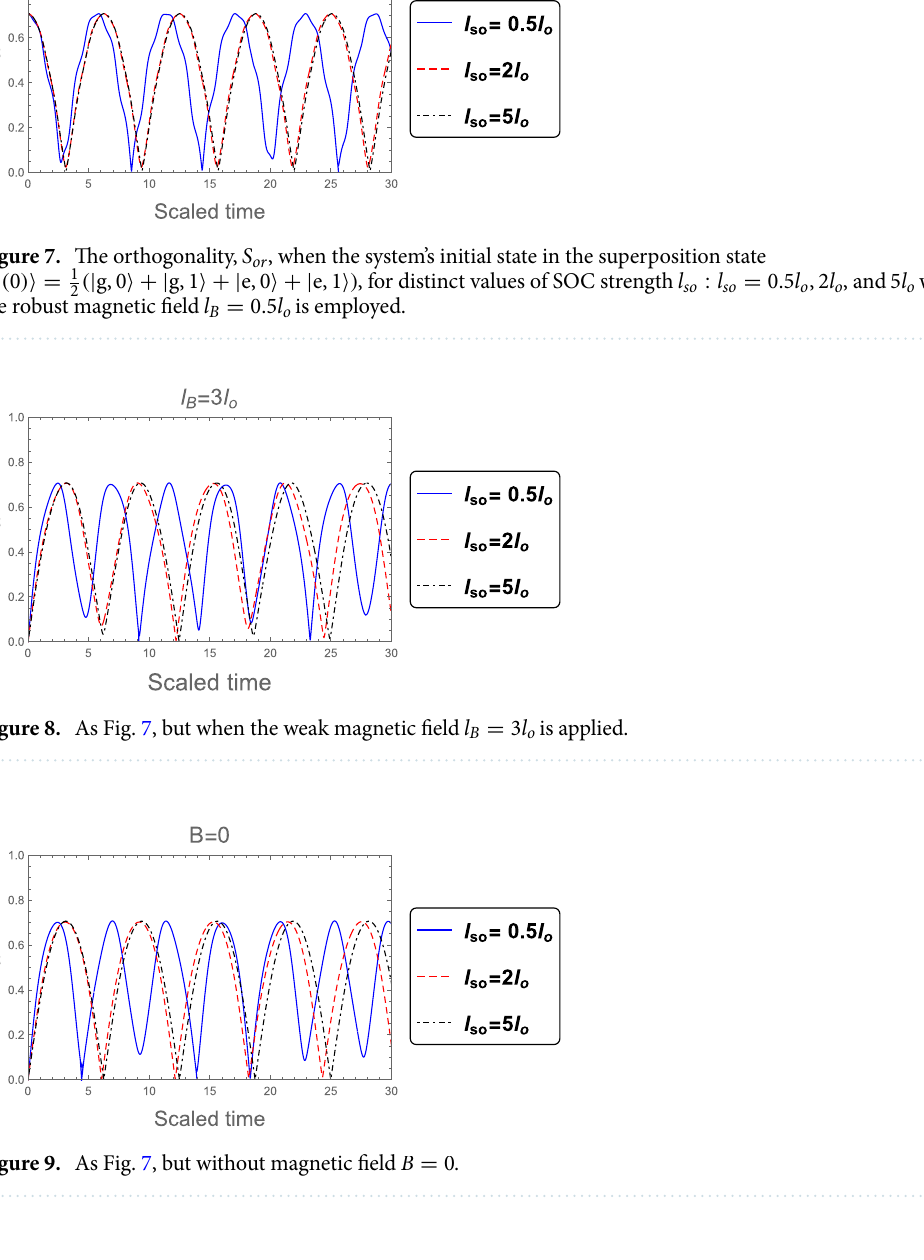
Figure 9. As Fig. 7, but without magnetic field B